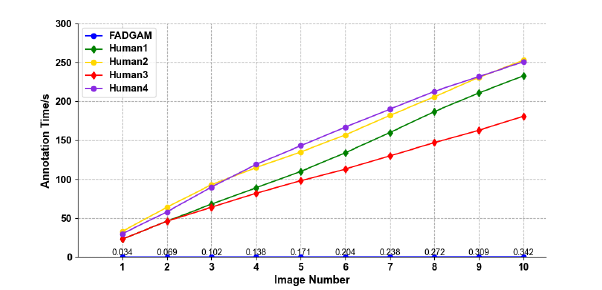
Figure 4. A comparison of the annotation time.